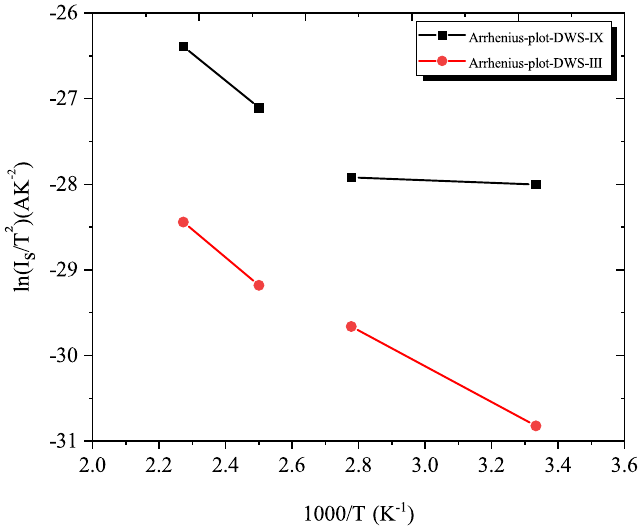
Figure 8. Activation energy plot of the ln ( I s / T 2 ) vs. 10 3 / T deduced from normalized I-V-T data for DWS# III and DWS# IX